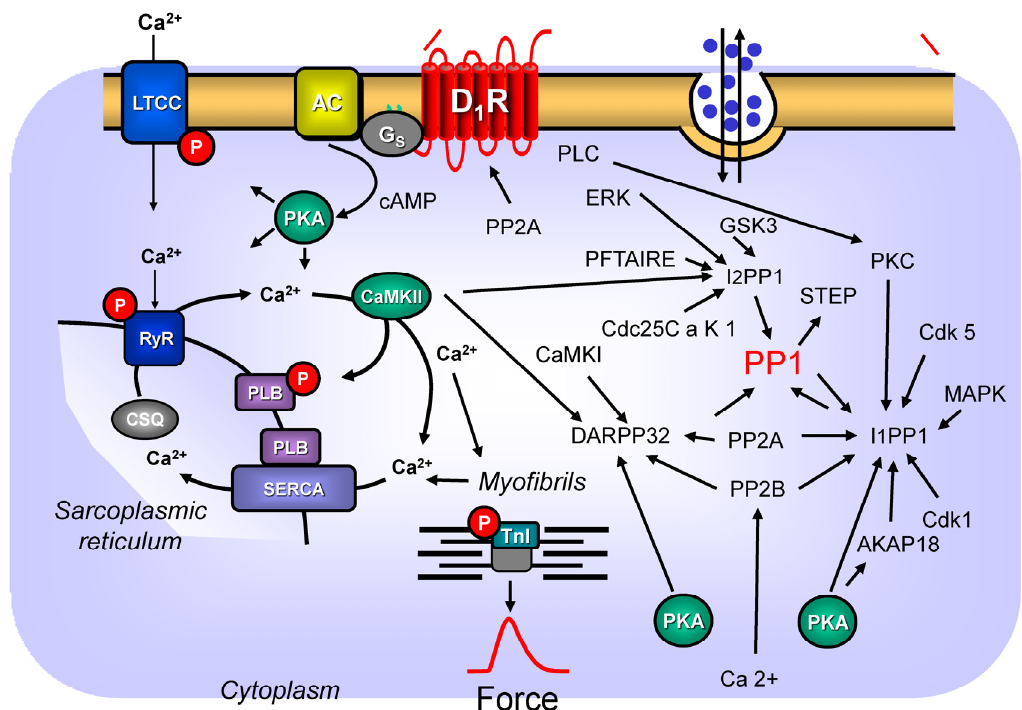
Figure 2. Speculative mechanisms of D 1 -dopamine receptor-mediated signal transduction in the heart. These pathways are known in the central nervous system, but they need to be elucidated in the human heart. Protein phosphorylations can be reversed via the action of protein phosphatases, such as PP1, PP2A, or PP2B. The so-called “dopamine- and cAMP-regulated phosphoproteins with an apparent weight of 32 kDa” (DARPP32), protein phosphatase-1-inhibitor-1 (I-1) protein phosphatase-1-inhibitor-2 (I-2), can inhibit PP1 and thus amplify the function of the D 1 -dopamine receptor. The inhibitory actions of I-1 and DARPP32 on PP1 are amplified after their phosphorylation by cAMP-dependent protein kinase (PKA). I-1 and DAPRP32 are dephosphorylated, and thus they are inactivated by PP2A and PP2B. PP2A might increase the insertion of D 1 -dopamine receptors (D 1 -R) into the sarcolemma. I-2 can be regulated in its activity to inhibit PP1 by the kinases shown here: casein kinase II (CamKII), glycogen synthase kinase 3 (GSK-3), a kinase abbreviated as PFTAIRE kinase (PFTAIRE), by ERK, and a Cdc25C-associated kinase 1 (Cdc25C a K). I-1 is phosphorylated, and its activity is altered by Cdk1, CdK5, protein kinase C (PKC), and a mitogen-activated kinase (MAPK). See text for further details.